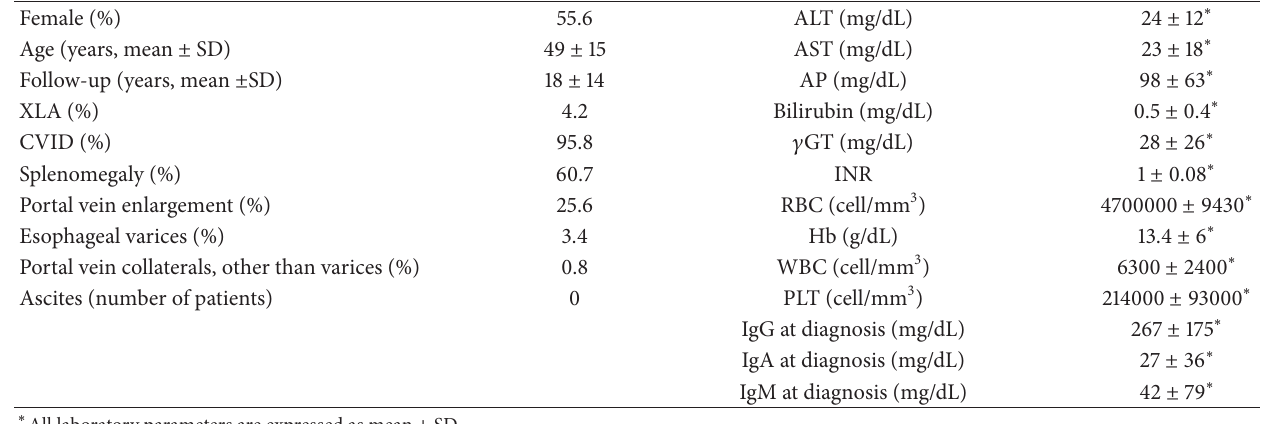
Table 1: Demographic, clinical, and laboratory characteristics of 117 PAD patients.